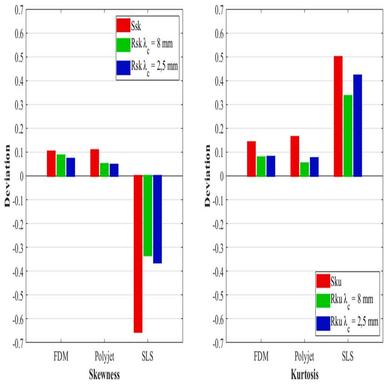
Skewness and kurtosis deviations from references.